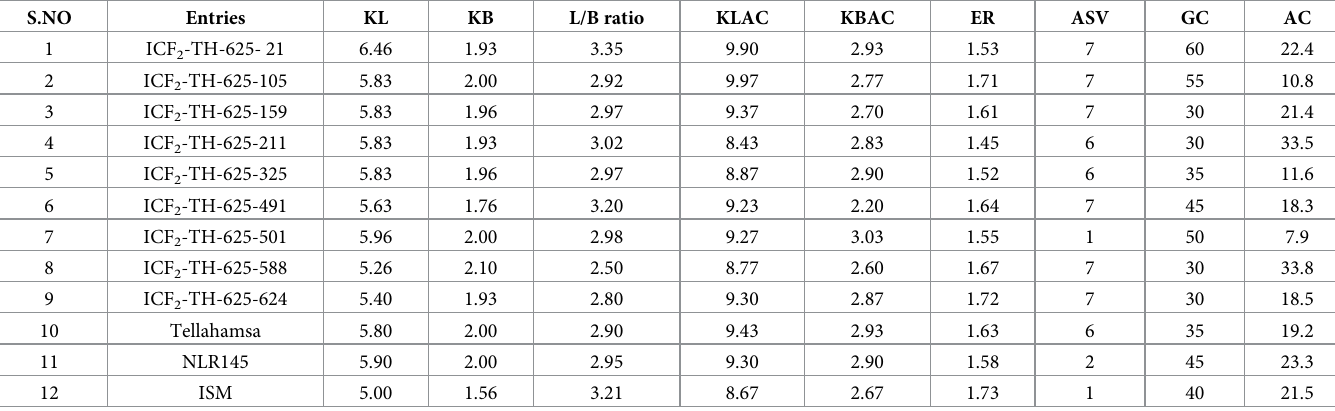
KL = kernel length, KB = kernel breadth, L/B ratio = length/ breadth ratio, KLAC = kernel length after cooking, KBAC = kernel breadth after cooking, ER = elongation ratio, ASV = alkali spreading value, GC = gel consistency and AC = amylose